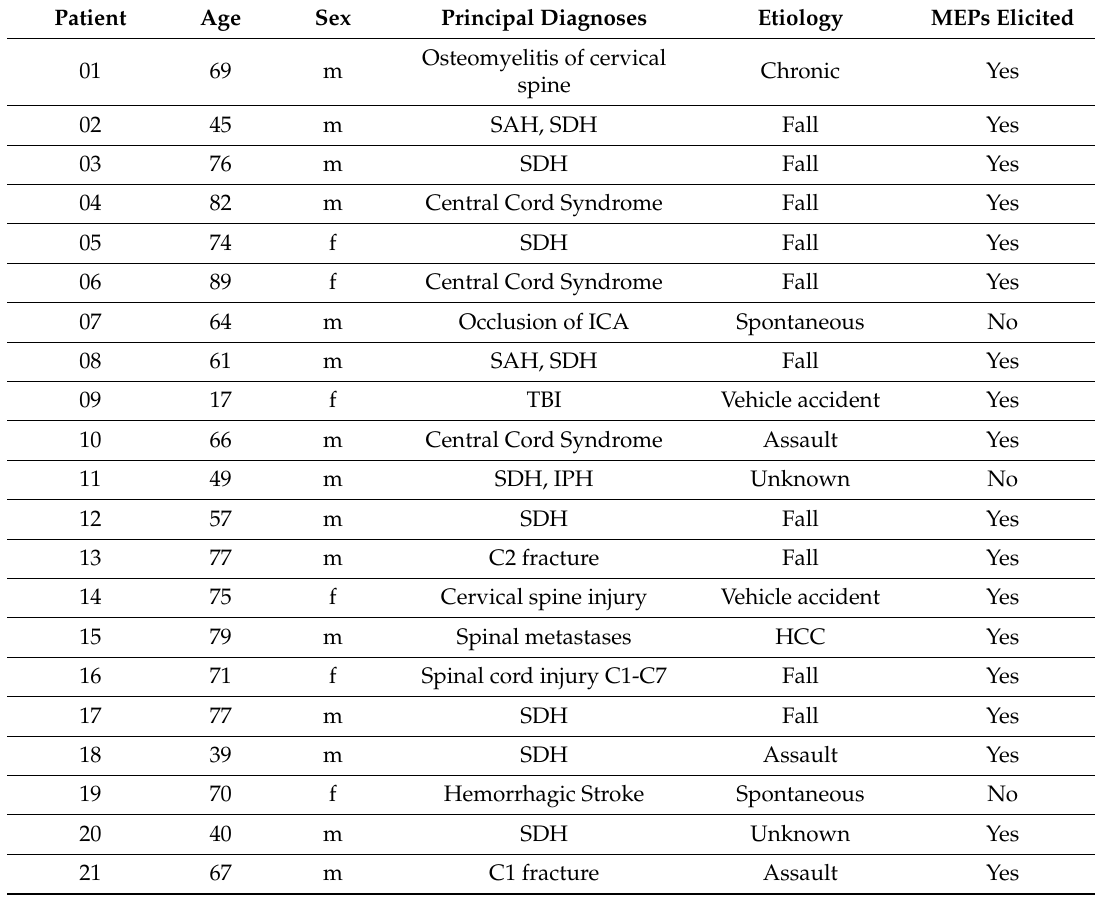
Table 2. Patient